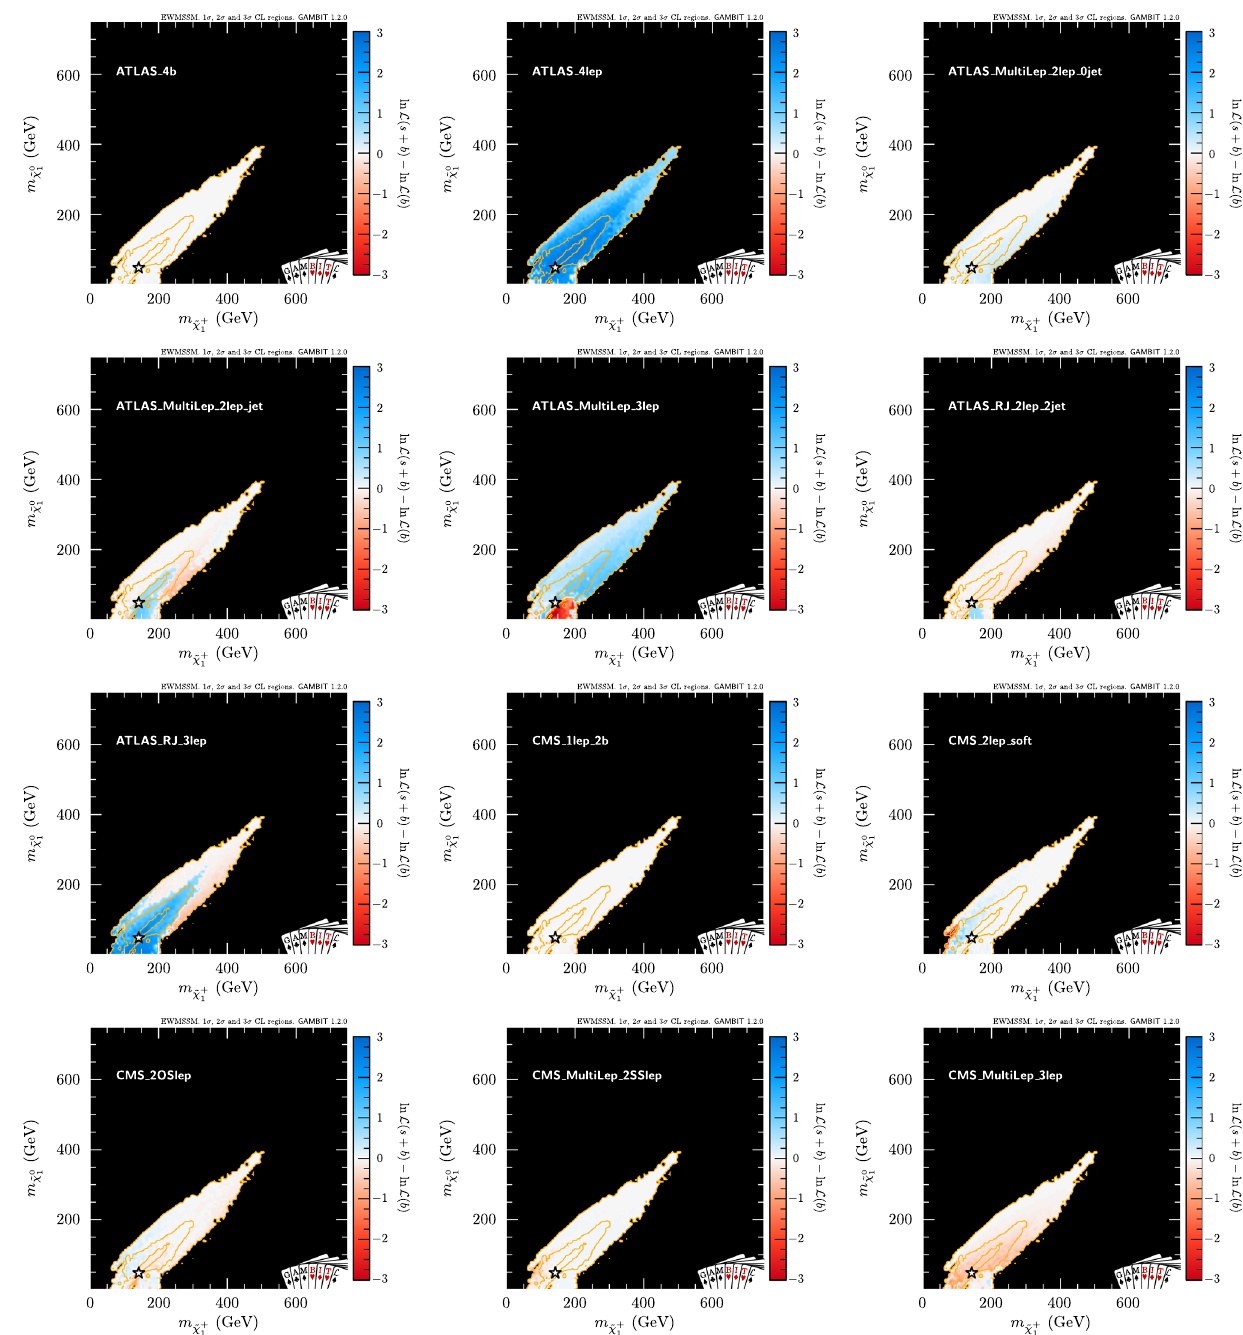
Fig. 8 The 1 σ , 2 σ and 3 σ regions (orange lines) preferred by our combination of searches in the ( m ˜ χ 0 twelve panels, the colors (where present) show the contribution to the